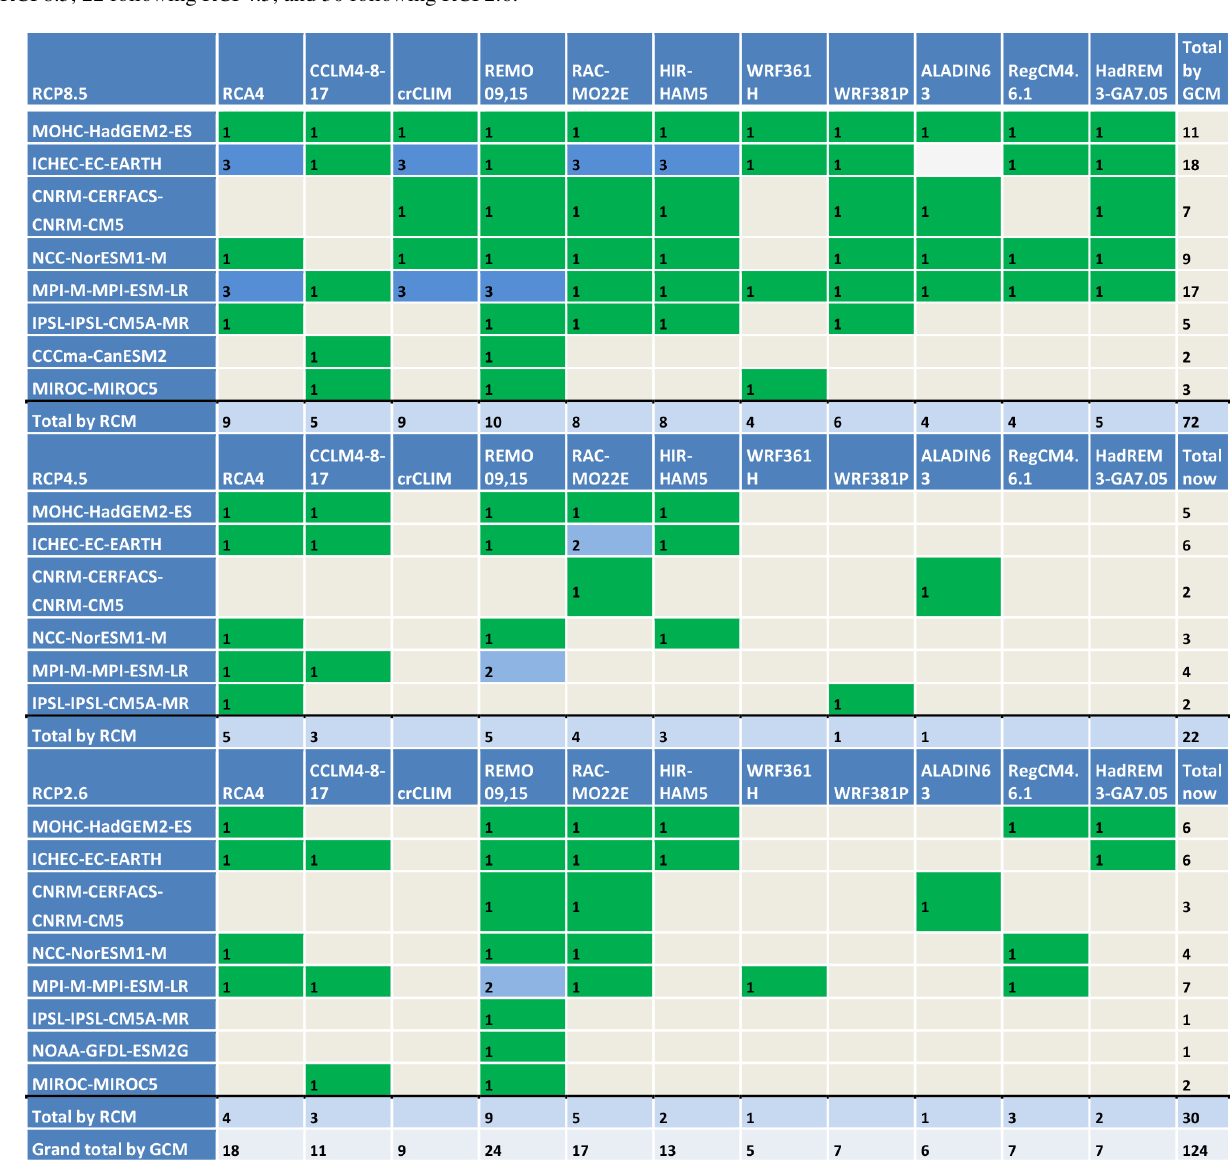
Table 1. Model simulations of the study. These constitute the entire set of seasonal average fields available from the Earth System Grid Federation (ESGF; http://esgf-data.dkrz.de, last access: 31 May 2021) archive in May 2021. There are 72 ensemble members following